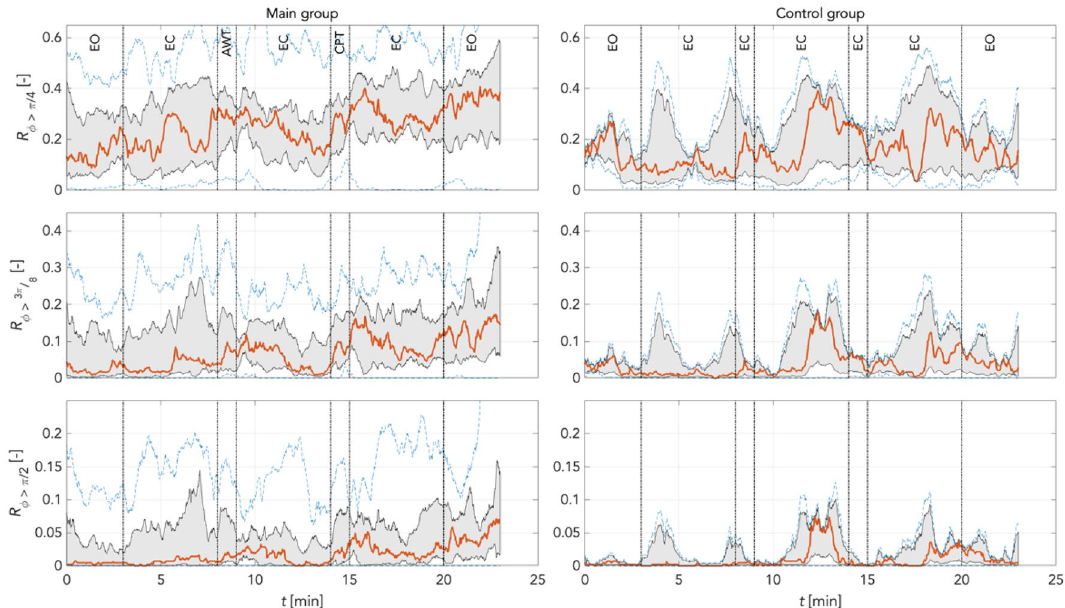
Figure 16. Phase desynchronization for different thresholds for all groups in the LF_Ke band (0.05 Hz – 0.12 Hz) completely including 0.1 Hz activity. Widely identical conditions in the main group as in the LF_PF frequency band. Phase desynchronizations in all thresholds for CPT as in LF_Pf frequency band. Stable course during CPT, rapid increases, slow decreases for about 3 min. Here no oscillations of higher frequency and amplitude. Increases of phase desynchronizations with time in all thresholds. In controls oscillations of comparable period duration, yet of different dynamics: steep rising edges followed by slow continuous activity (8 min, 12 min, 17 min). No increases with time in controls. Red: median curve, black vertical lines: stages of the experiment, grey area bounds: 25th and 75th percentiles; blue dashed lines: min and max